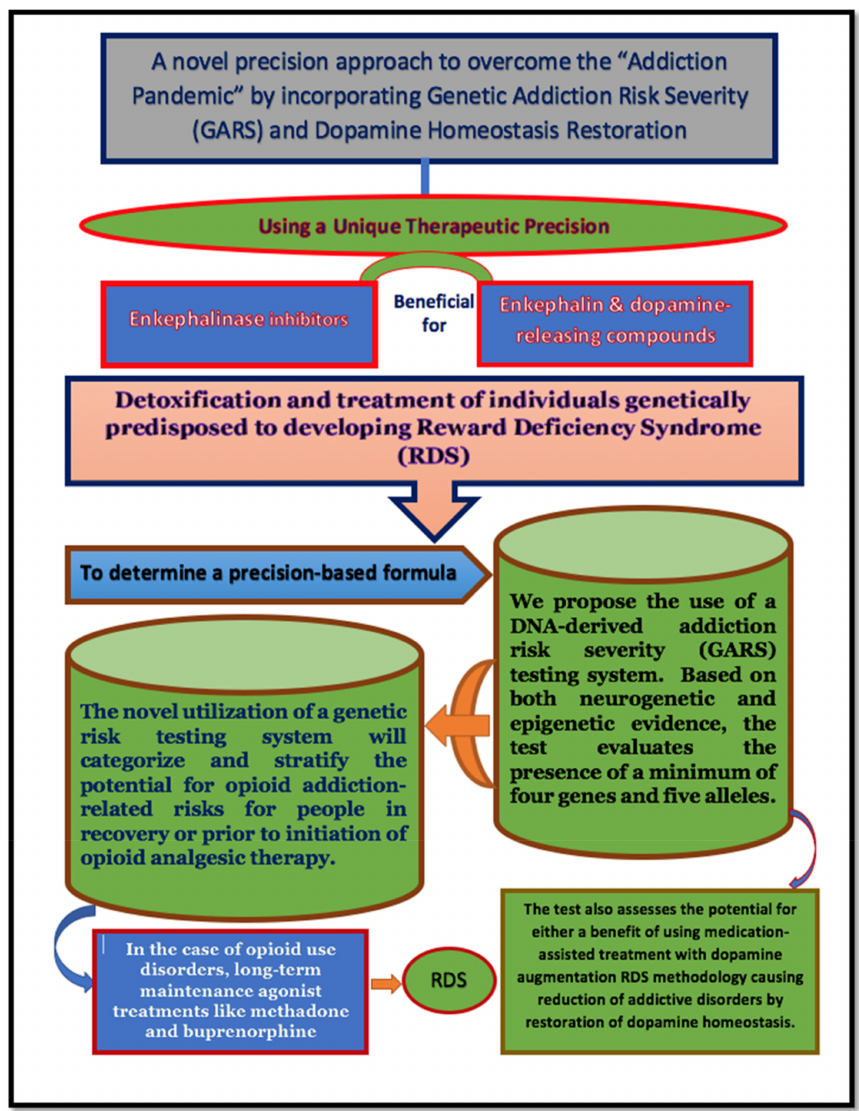
Figure 2. This figure is a graphic illustration of how the research and concepts explored here may be applied from bench to